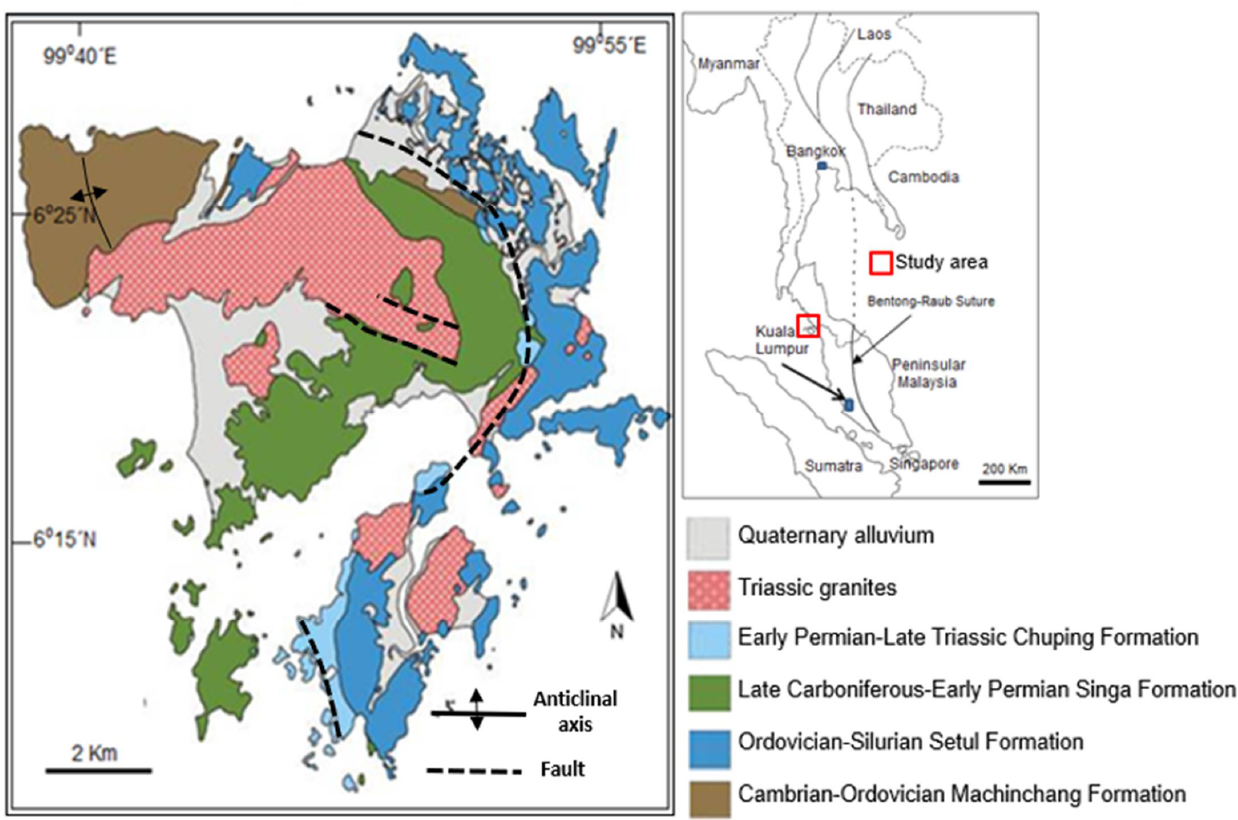
Figure 1. Geological sketch map of Langkawi Islands, Malaysia (modified after Che et al., 2008) [11].